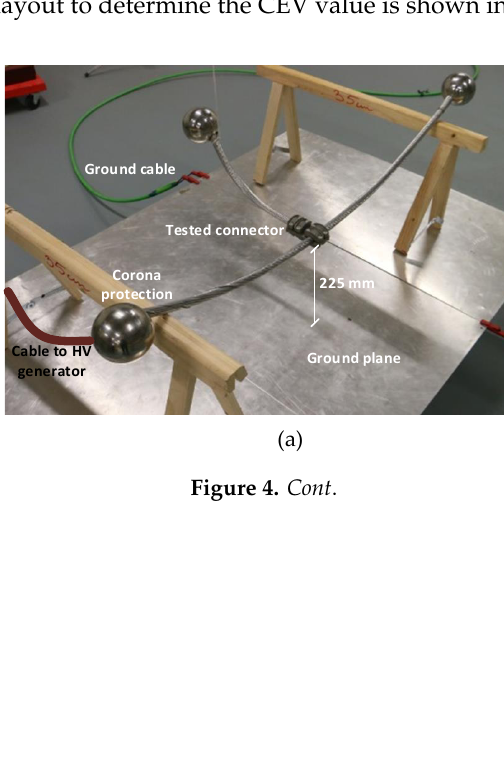
Figure 3. Straight flat lines where the surface roughness measurements were